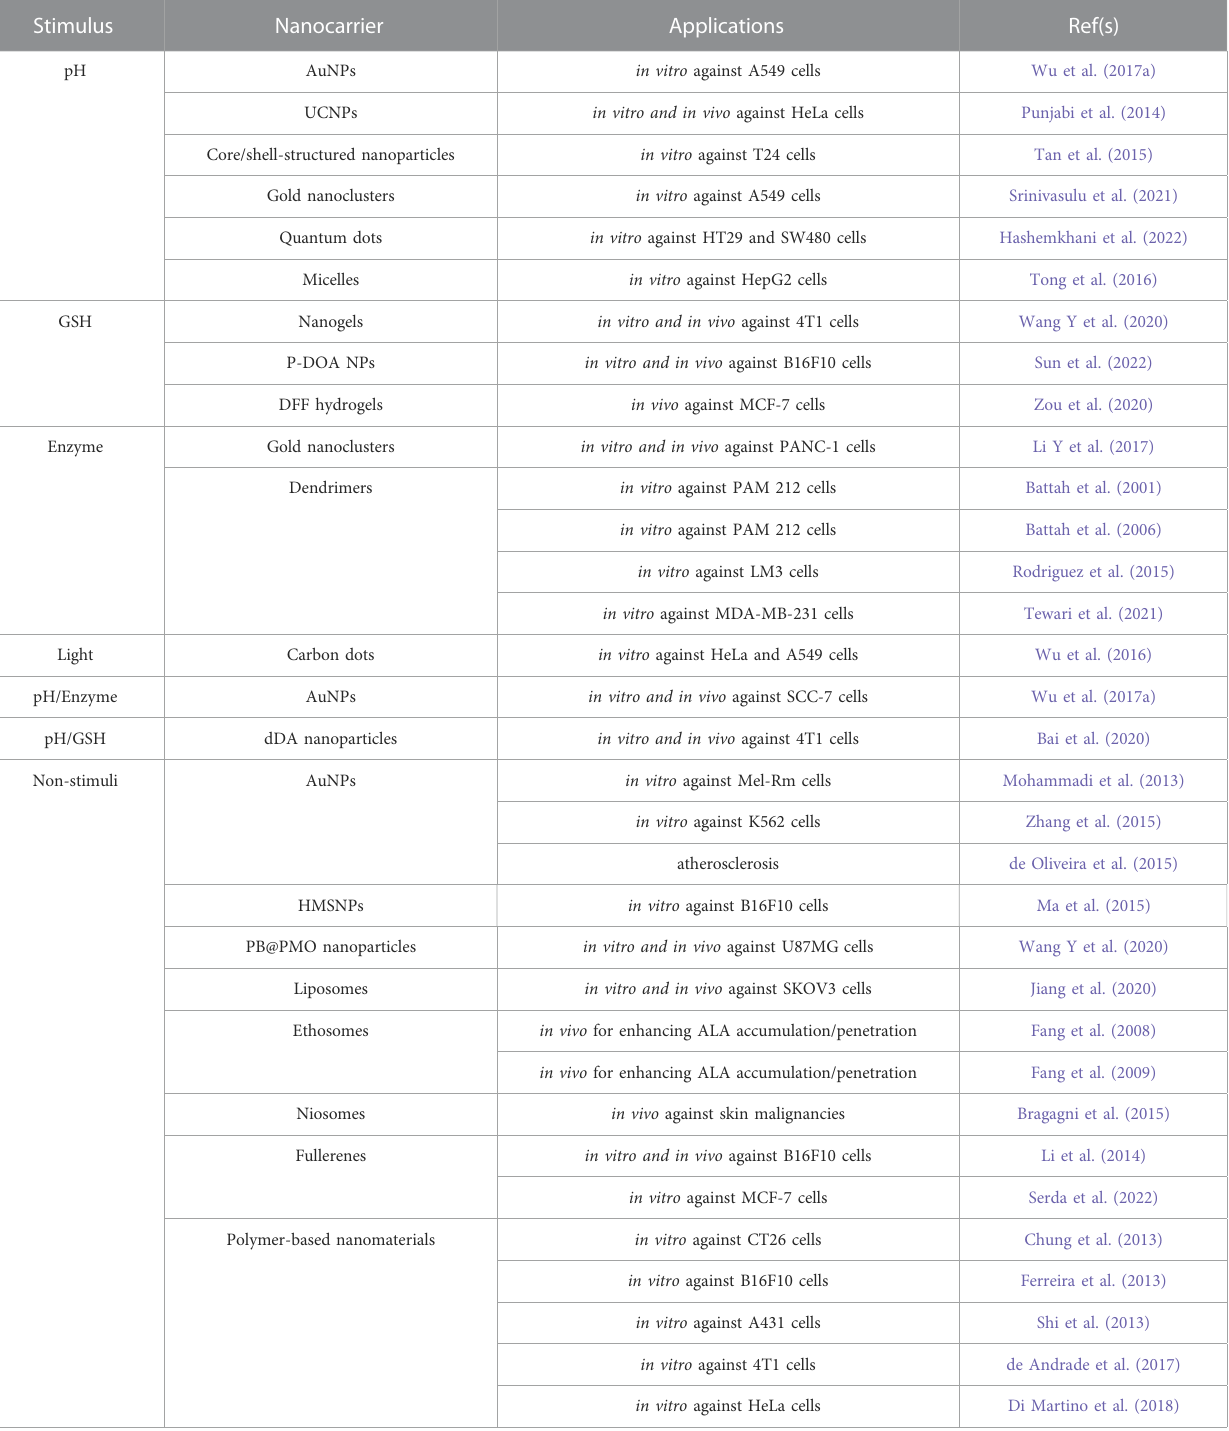
TABLE 2 A summary of ALA-based prodrugs for improved PDT using